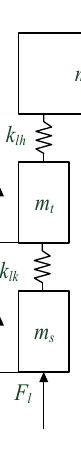
Figure 3. The dynamic model of the human body with ground reaction force.